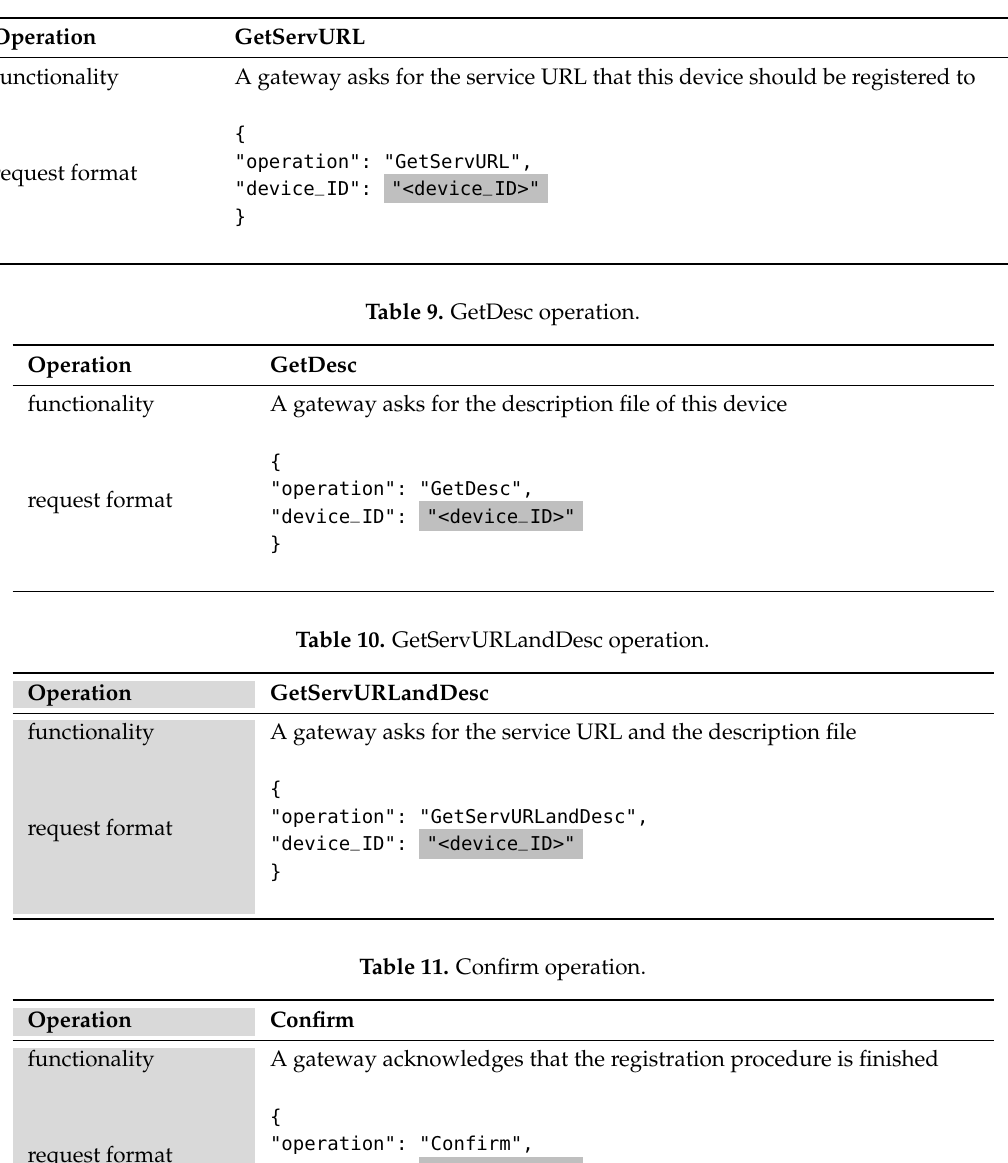
Table 8. GetServURL operation.